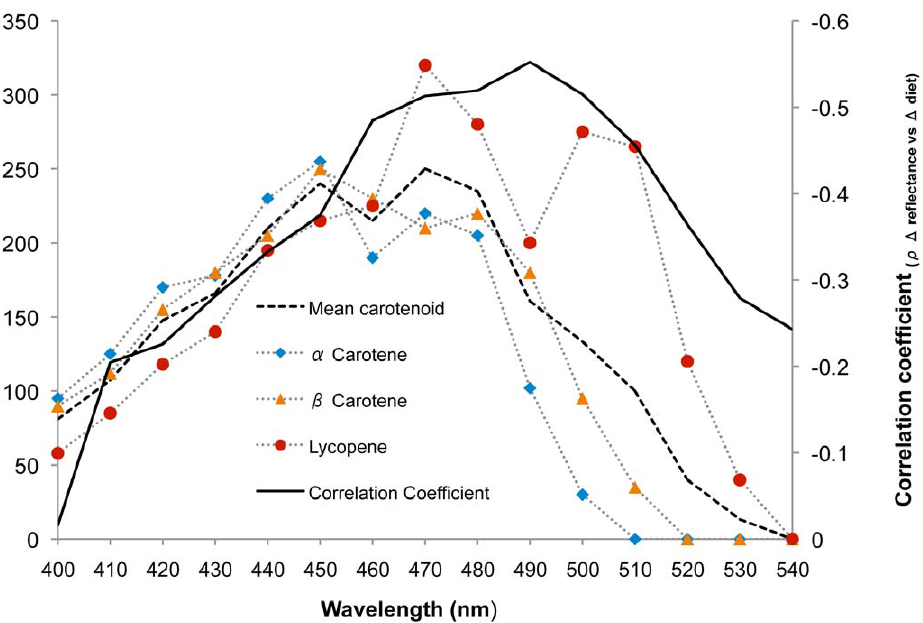
Figure 5. Diet-linked skin reflectance changes track common carotenoids. Solid black line - Spearman correlation coefficients ( r D reflectance vs D diet ) of the relationships between fruit and vegetable consumption change (from week 0 to 6) and average skin reflectance change. Dashed bold line shows the mean absorption spectra [cm 2 1 (mg/ml) 2 1 ] for three common carotenoids, which are individually plotted (blue rhombi - a -carotene, orange triangles - b -carotene and red circles - lycopene). doi:10.1371/journal.pone.0032988.g005 ( r = 2 0.427, p = .113), but was significantly associated with the reflectance, no association was seen with the absorption spectra of a -carotene ( r = 2 0.386, p = .156) but the correlation strength was absorption spectra of lycopene ( r = 2 0.829, p , .001) and margin- ally correlated with the mean absorption spectra of these three associated with the absorption spectra of b -carotene ( r = 2 0.588, p = .021), lycopene ( r = 2 0.893, p , .001) and the mean absorption carotenoid pigments ( r = 2 0.511, p =.052). For average facial skin